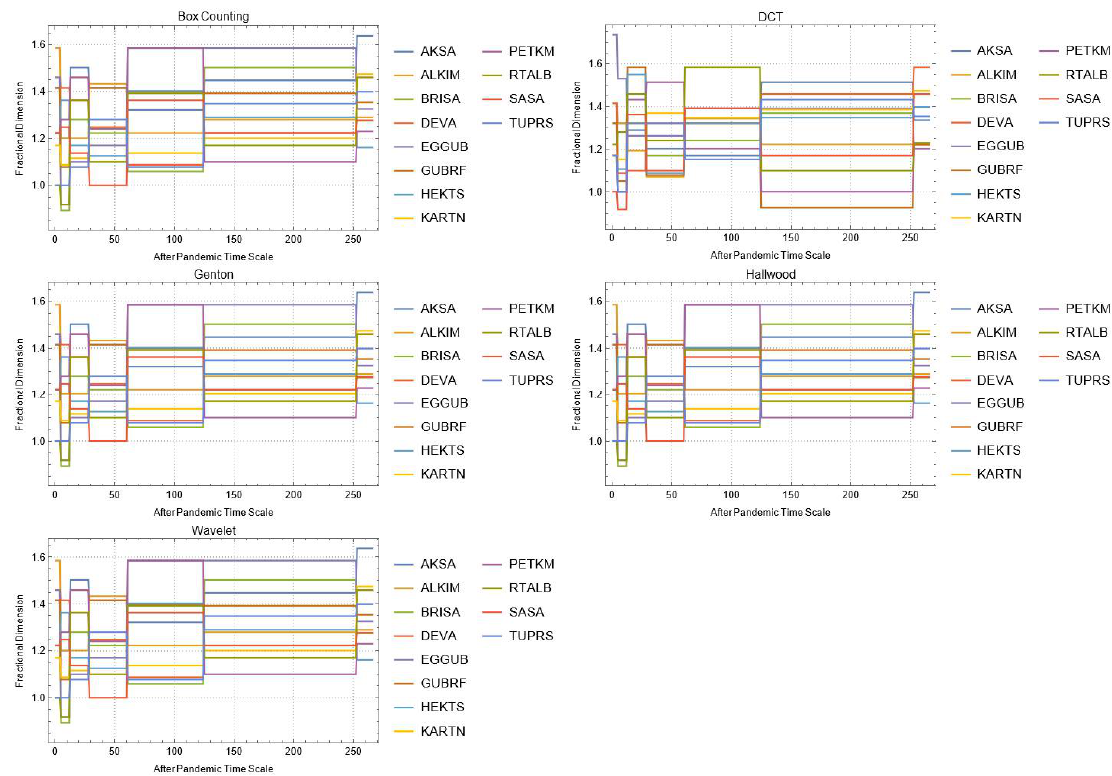
Figure A19. Daily changes of fractal dimensions after the pandemic (food, beverage and tobacco).